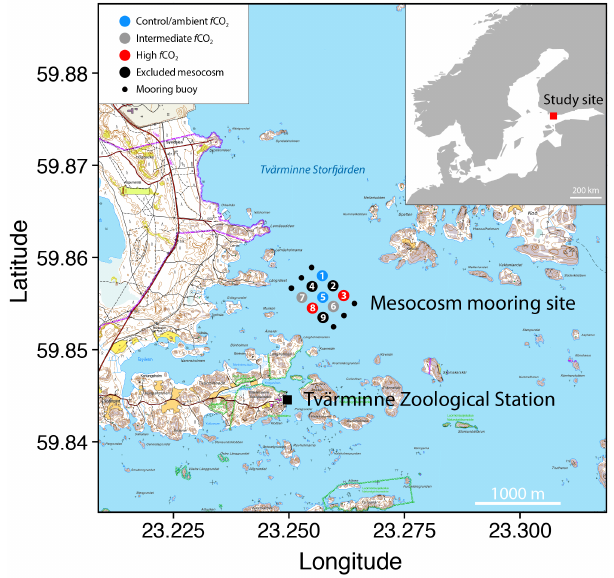
Figure 2. Map of study area (inset) and mesocosm mooring site in the Tvärminne Storfjärden, off the Hanko Peninsula close to the entrance to the Gulf of Finland in the Baltic Sea. Mesocosm repre- sentation is not to scale. Map contains data from the National Land Survey of Finland Topographic Database, accessed March